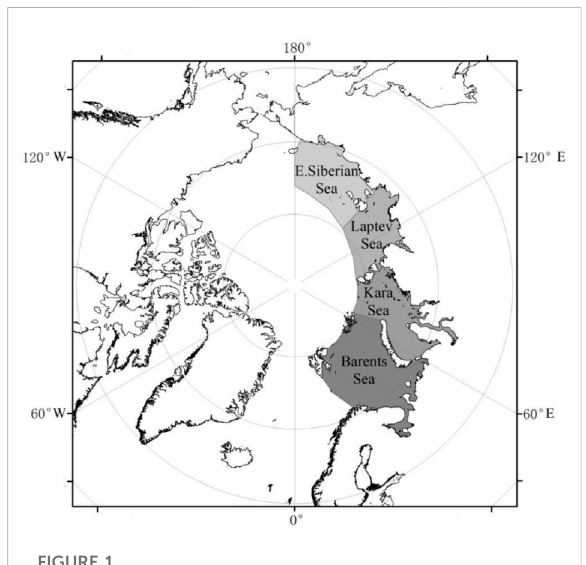
FIGURE 1 MapoftheNEPincludingthelocationoftheBarentsSea,Kara Sea, Laptev Sea, and East Siberian